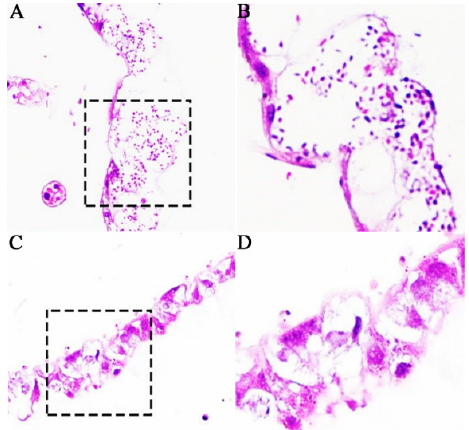
Figure 2. Microscopic observation of paraffin sections of N. ceranae -inoculated and un-inoculated A. c. cerana workers’ midguts. ( A ) Worker’s midgut at 11 dpi with N. ceranae under 200 times amplifi- cation. ( B ) Worker’s midgut at 11 dpi with N. ceranae under 400 times amplification. ( C ) Worker’s midgut at 11 dpi without N. ceranae under 200 times amplification. ( D ) Worker’s midgut at 11 dpi without N. ceranae under 400 times amplification. Black dashed box shows the region for observation under 400 times